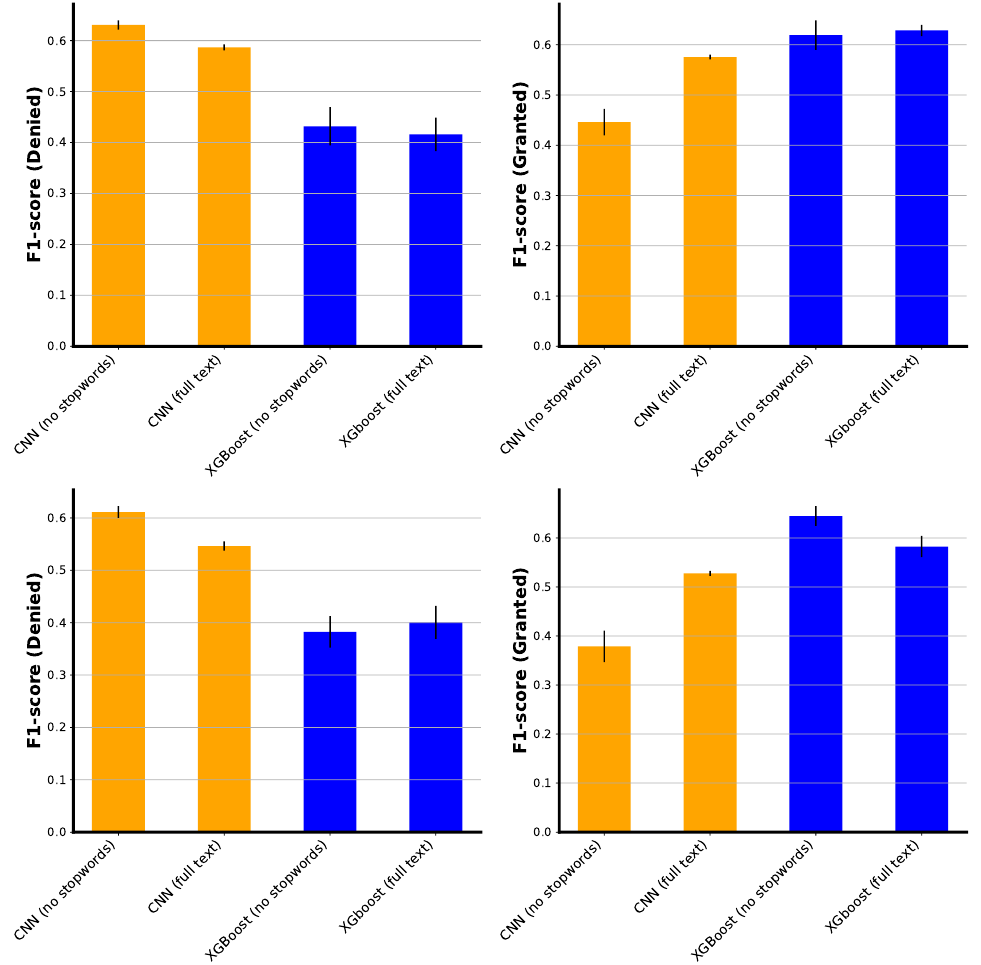
Figure 8. Metrics for XGBoost/TF-IDF and CNN-Attention models for predicting the institution outcome (grant/denial) using the full text of the patent owner’s preliminary response brief. The plots show averages with standard deviations as error bars for five (CNN) and three (XGBoost) training runs. The training set consists of 2631 cases filed between 1 July 2018 and 30 November 2020. Results are shown for no maximum vocabulary size but rejecting stop words (labeled “no stop words” as described in Section 3.2, and limiting the vocabulary to 20,000 words but including stop words (“full text”). The F1 -score (harmonic mean between precision and recall) is shown for the grant and denial classes for: ( top ) cases filed between 1 December 2020 and 31 March 2021, and ( bottom ) cases filed between 1 January 2021 and 31 March 2021 (see accompanying text for further